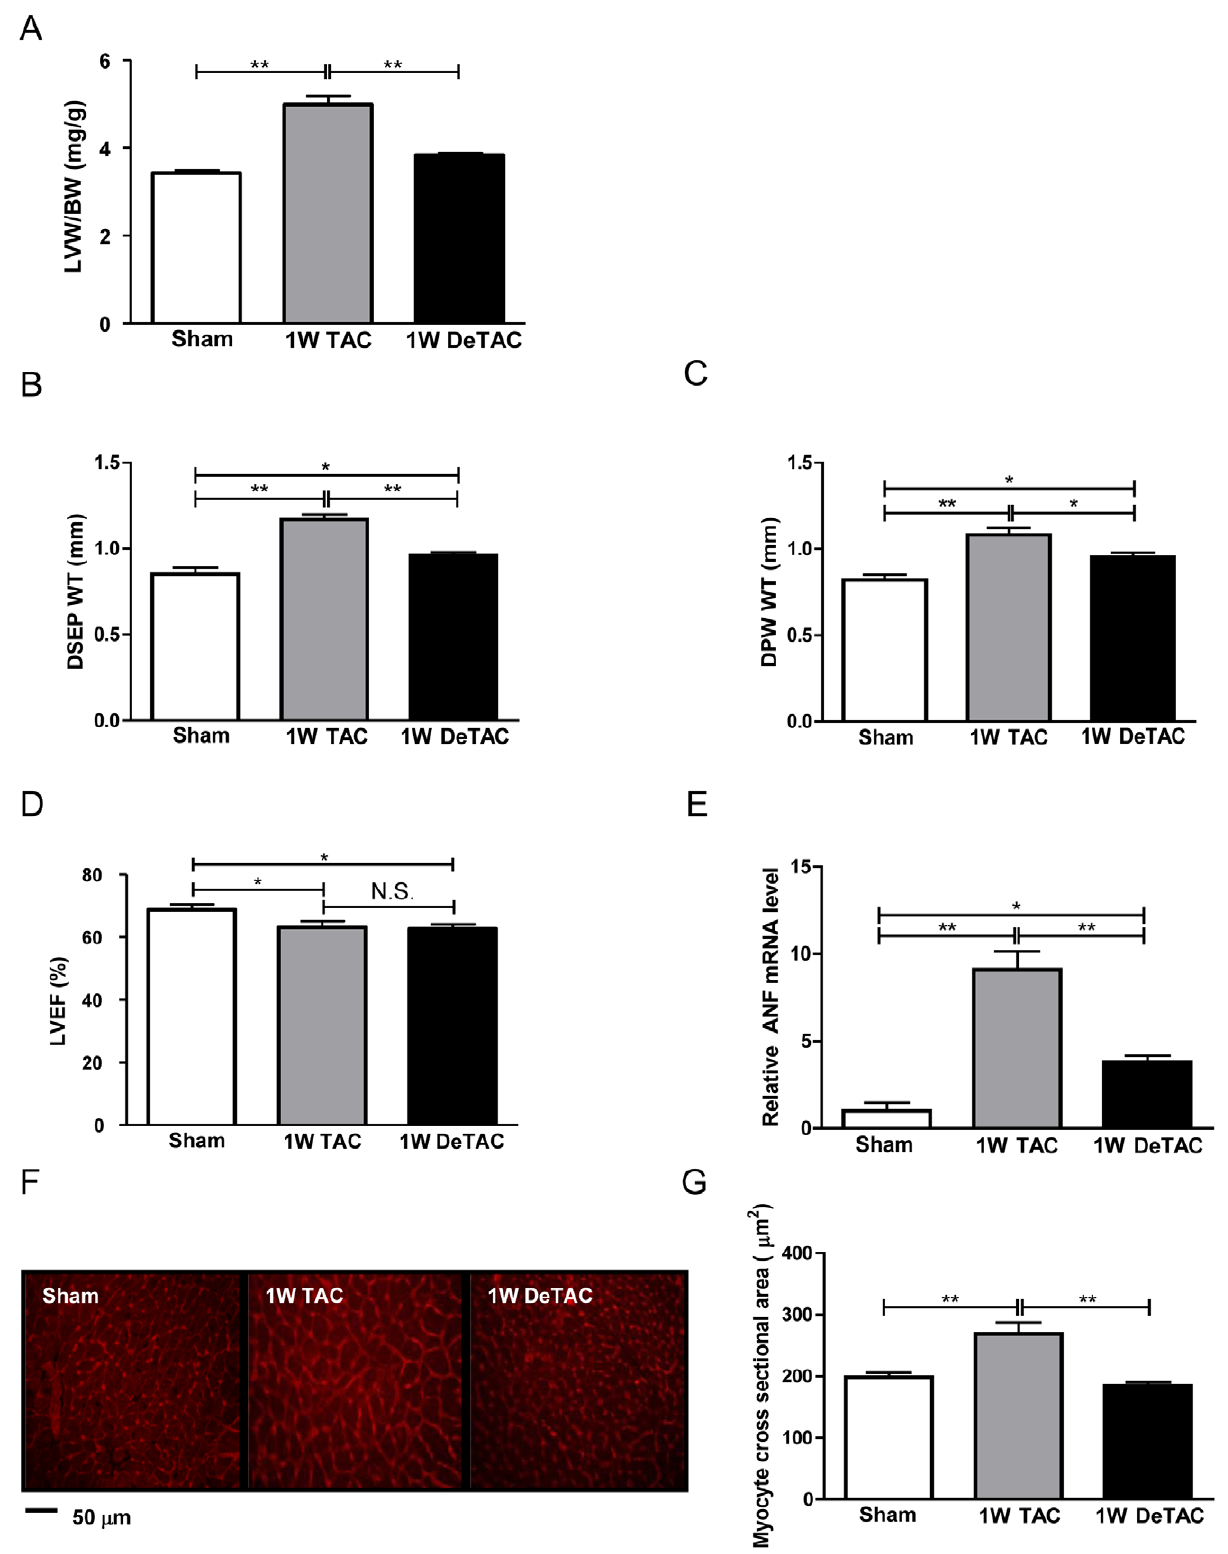
Figure 1. Left ventricular unloading induces regression of cardiac hypertrophy. C57BL/6 mice were subjected to pressure overload caused by thoracic aortic constriction for 1 week (1W TAC), followed by cardiac unloading by removal of the constriction for 1 week (1W DeTAC). A) Left ventricular weight/body weight (LVW/BW). B) Diastolic septal wall thickness (DSEP WT), C) diastolic posterior wall thickness (DPW WT), and D) left ventricular ejection fraction (LVEF), as evaluated by echocardiographic analyses. E) mRNA level of atrial natriuretic factor (ANF), evaluated by qRT-PCR.